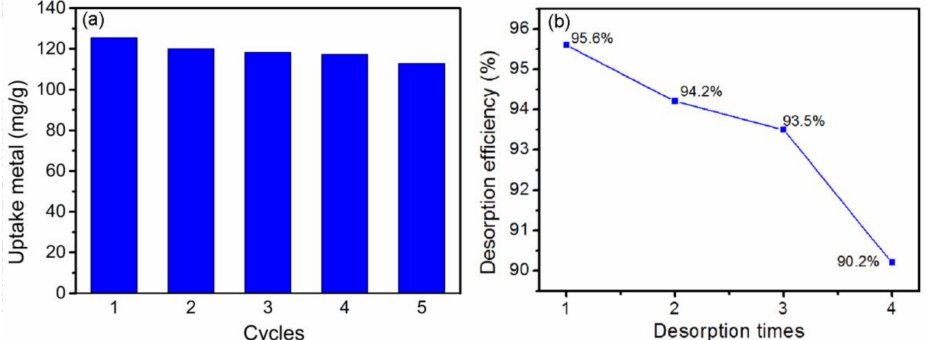
Figure 12. ( a ) Regeneration studies of g-PAM/OVerm after five cycles; and ( b ) evolution of the desorption efficiencies during four-time